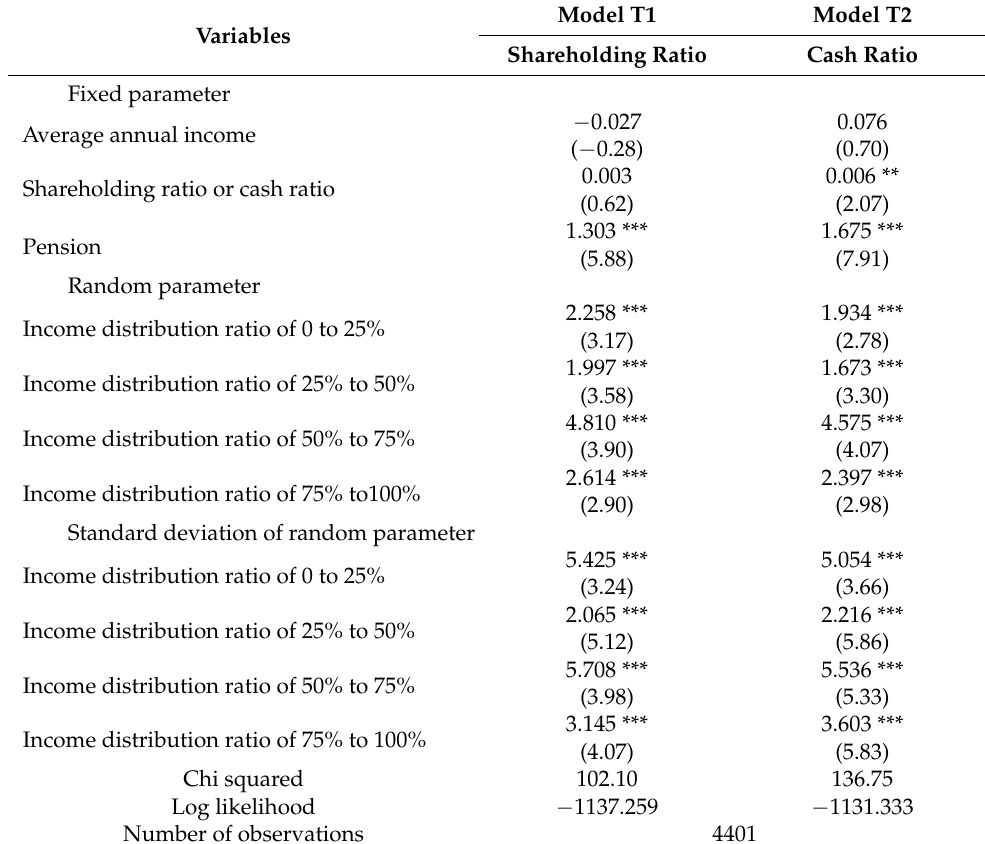
Table 5. Estimation results of random parameter Logit model based on total sample under different income distribution